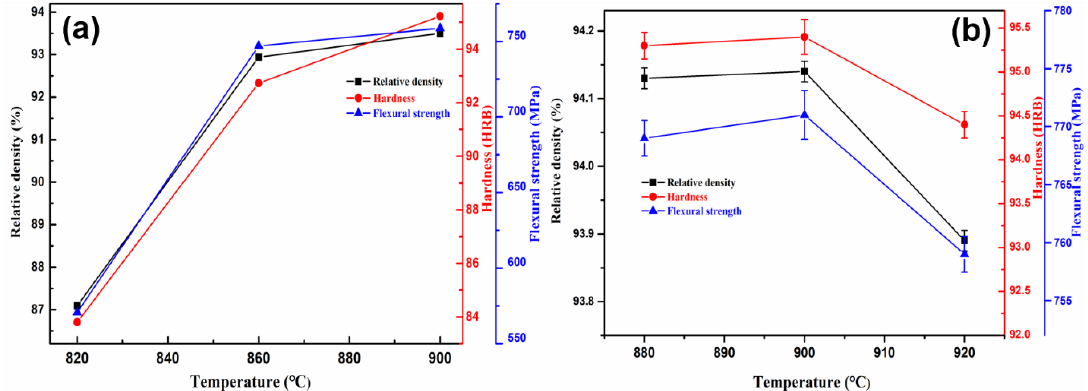
Figure 2. The effect of sintering temperature on the mechanical properties of the samples (( a ) Orthogonal experimental; and, ( b ) Conditional experiment (375 MPa, 35 min)). Table 4. Performance comparison between microwave and conventional sintered samples. Table 4. Performance comparison between microwave and conventional sintered